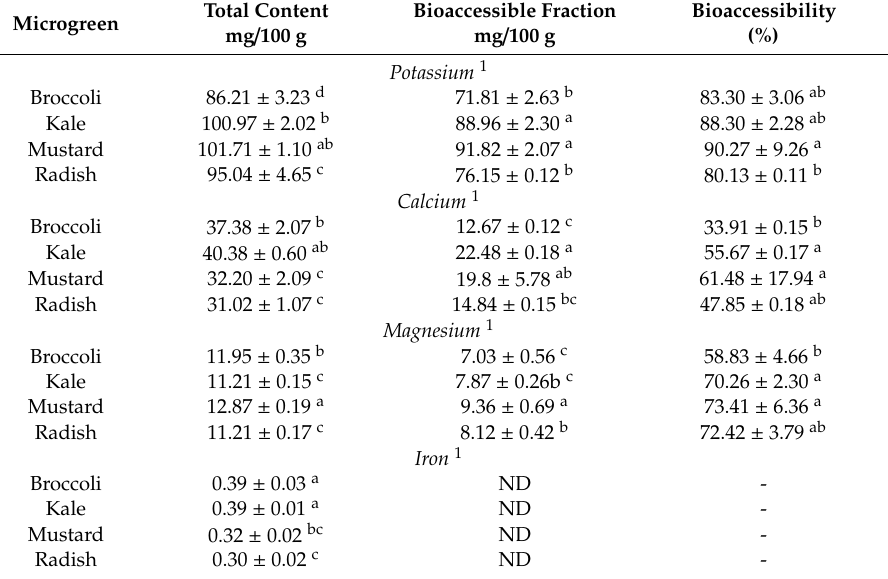
Table 4. Mineral content before and after simulated gastrointestinal digestion in